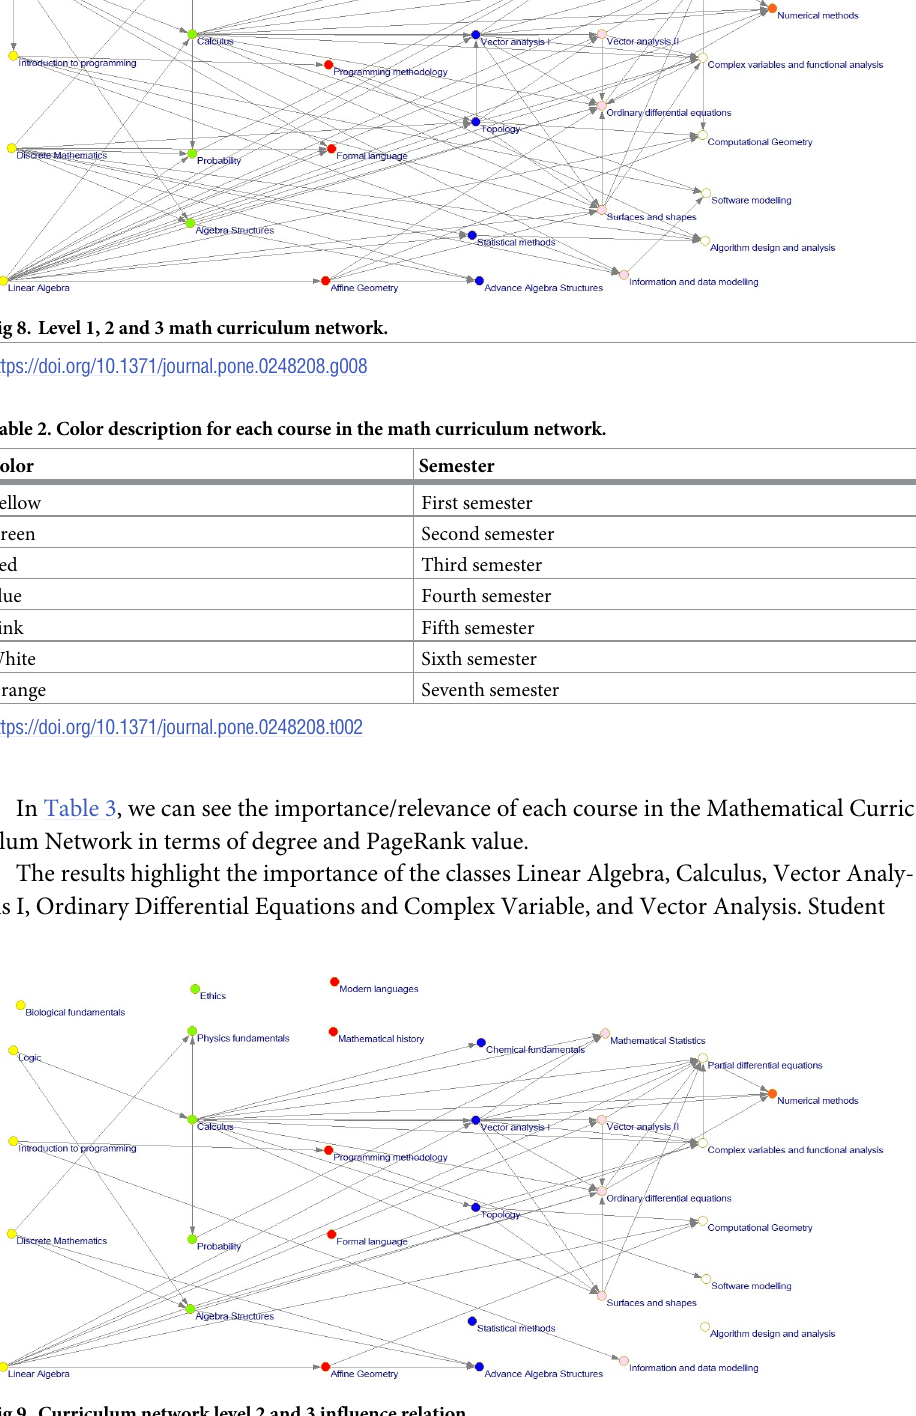
Fig 9. Curriculum network level 2 and 3 influence